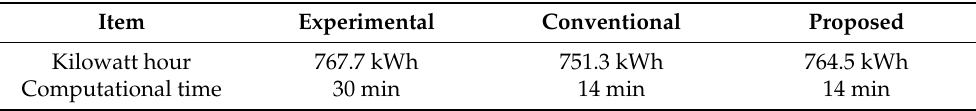
Table 5. Comparison of kilowatt hours and computational